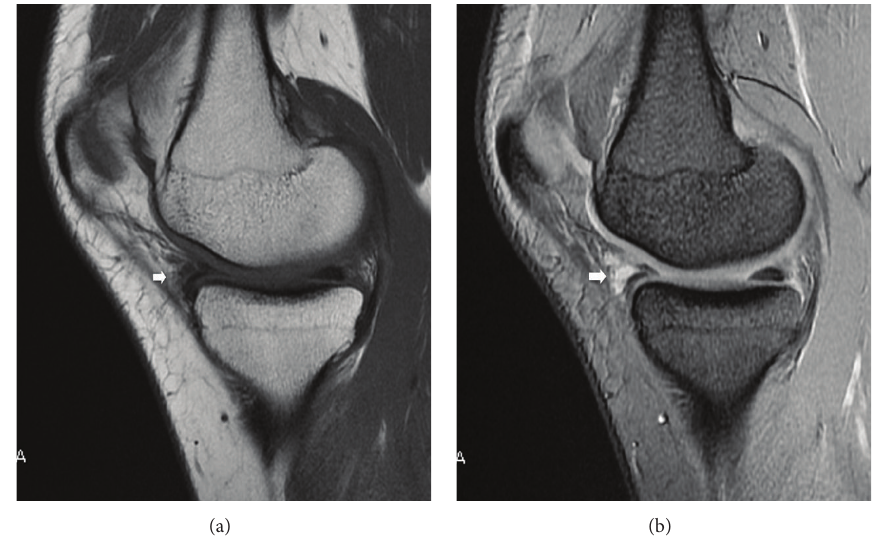
Figure 1: Preoperative magnetic resonance images of the right knee showed a cystic lesion adjacent to the anterior horn of the medial meniscus. (a) Sagittal T1-weighted image and (b) Sagittal T2-weighted image. White arrows indicate the lesion.